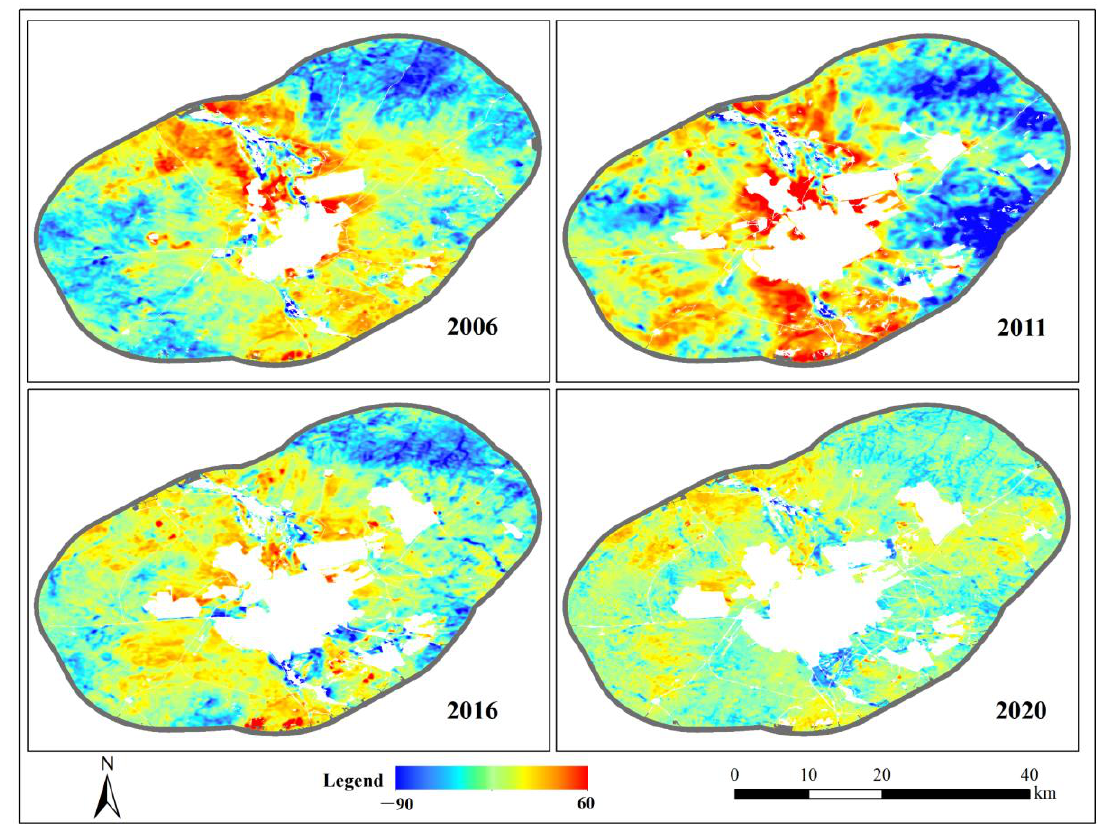
Figure 7. Hot spots mapping of the impact of human activities on NPP.